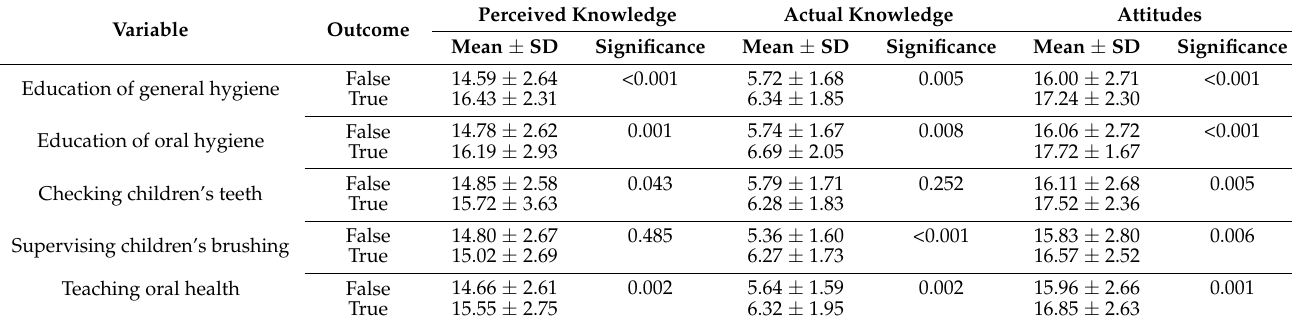
Table 10. Impact of elementary schoolteachers’ oral health knowledge and attitudes on their practice.